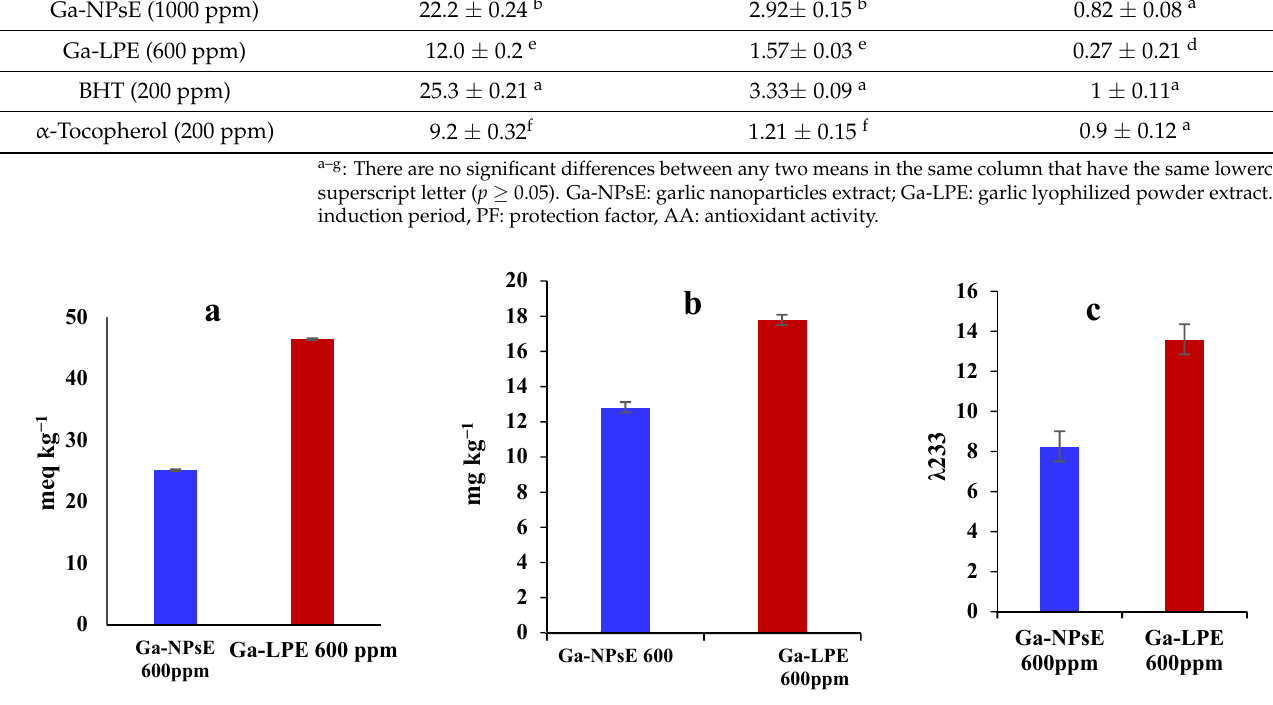
Figure 2. Effect of Ga-NPsE and Ga-LPE (600 ppm) on the oxidation parameters of SFO after 24 days of storage. Peroxide value ( a ), p-anisidine value ( b ), and conjugated dienes ( c ).